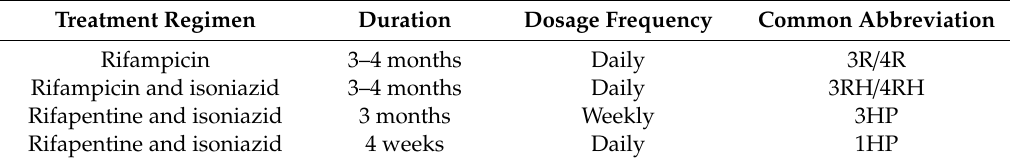
Table 4. Alternative shorter TB preventive therapy